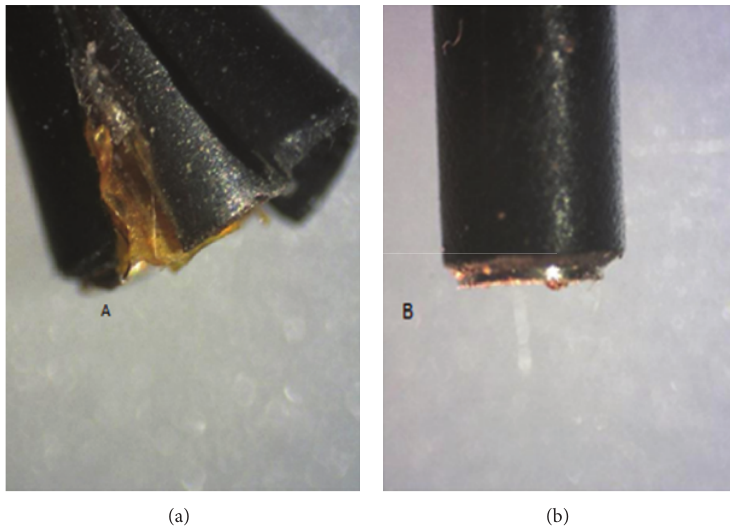
Figure 4: Destroyed (a) and intact (b) probes of the electrohydraulic device (magnification of 60).